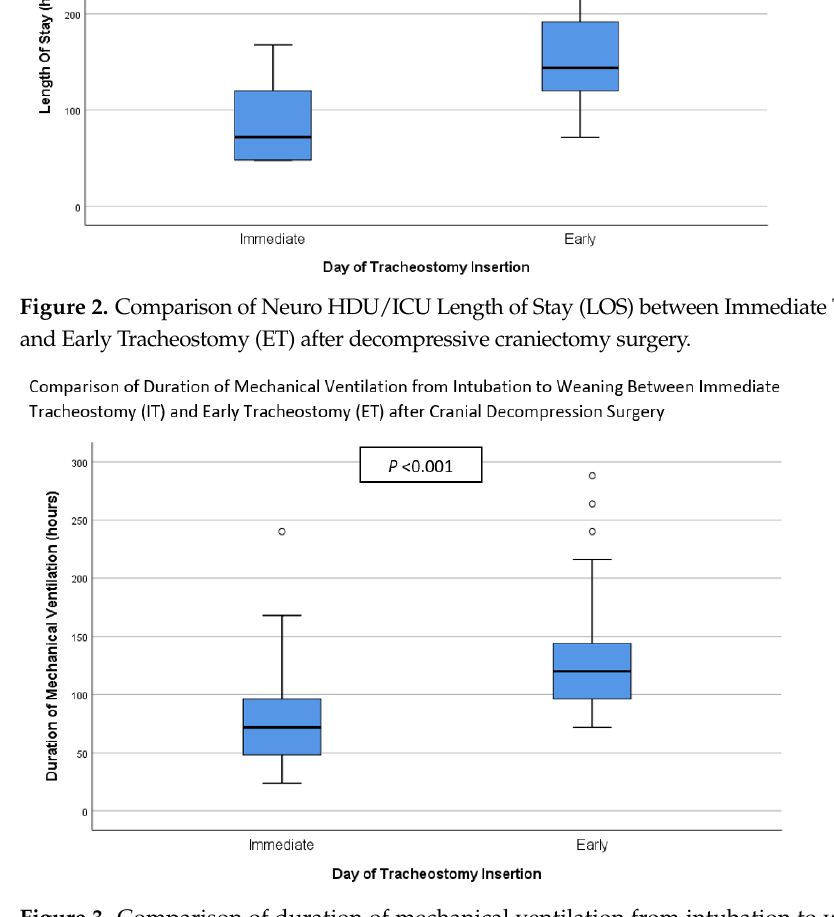
Figure 3. Comparison of duration of mechanical ventilation from intubation to weaning between Immediate Tracheostomy (IT) and Early Tracheostomy (ET) after decompressive craniectomy sur- gery. Table 3. Glasgow Outcome Score (GOS) of patients who underwent Immediate Tracheostomy (IT) and Early Tracheostomy (ET) after decompressive craniectomy